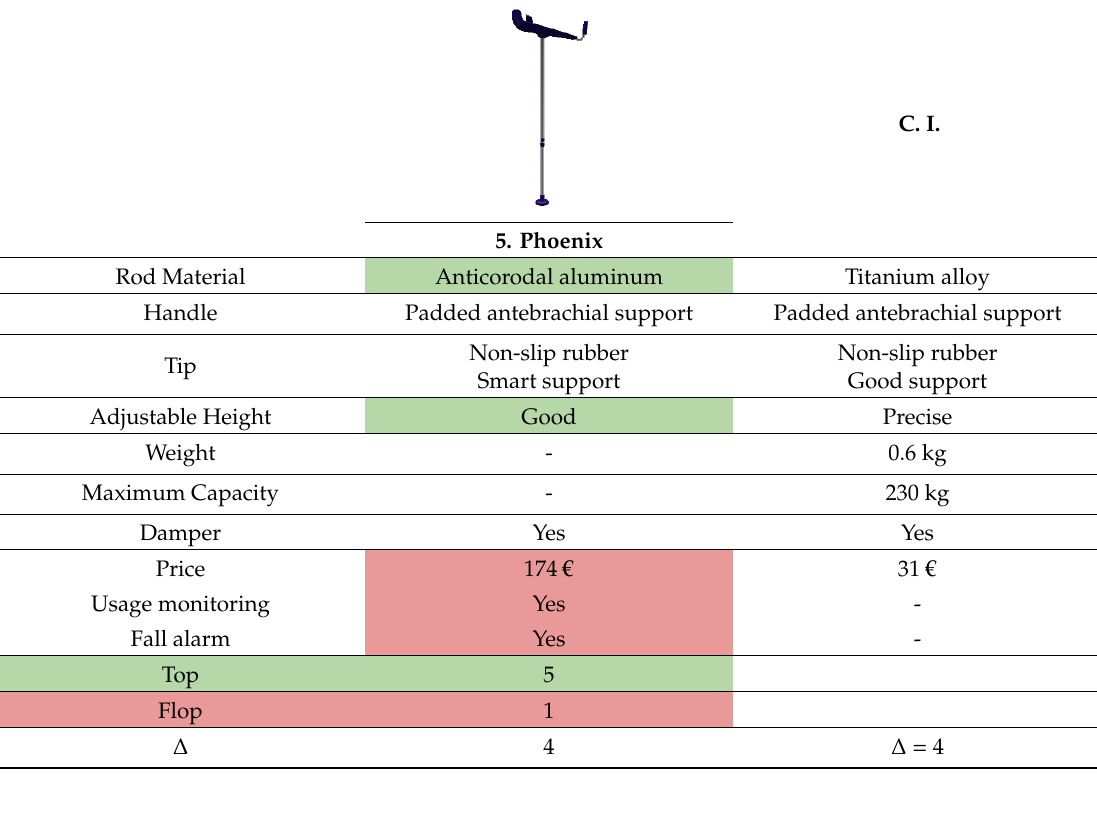
Table 10. Top-Flop Analysis of the new product.